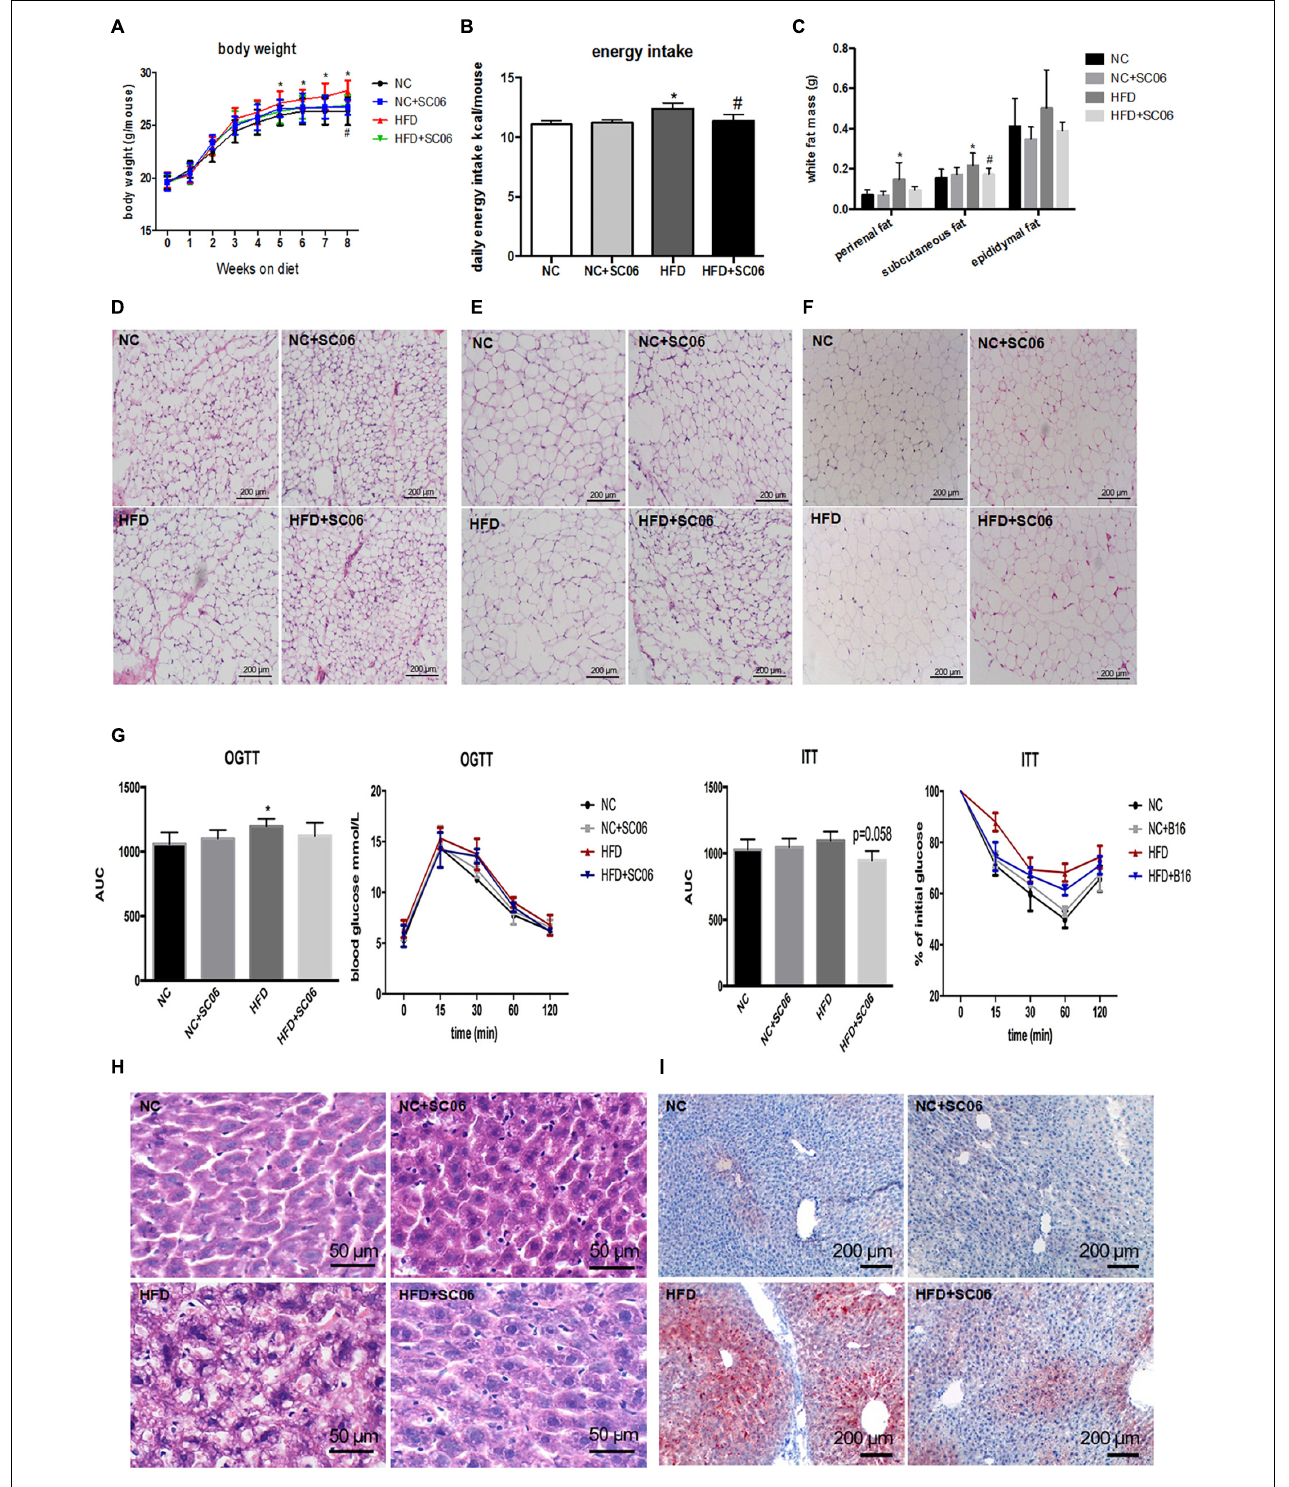
FIGURE 1 | SC06 attenuated HFD-induced obesity, insulin resistance and hepatic steatosis. (A) Body weight, (B) daily energy intake, (C) partial white fat mass, (D) subcutaneous adipocyte morphology, (E) perirenal adipocyte morphology, (F) epididymal adipocyte morphology, (G) , OGTT and ITT, AUC means area under the curve. (H) HE liver sections, (I) oil-red O liver section. Results are expressed as means ± SD ( n = 15 for body weight, energy intake, and fat mass; n = 4 for tissue morphology). Differences between groups were determined by one-way ANOVA followed by Tukey’s t -test. Significant differences between HFD versus NC are indicated as ∗ p < 0.05. Significant differences between HFD versus HFD+SC06 are indicated as # p < 0.05.